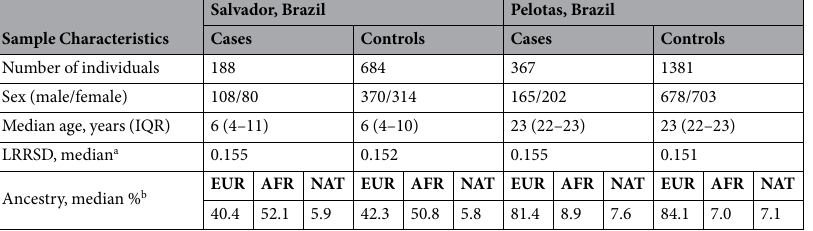
Table 1. Characteristics of the studied samples (after quality control). a Log 2 of R ratio standard deviation. b Ancestry proportions (ADMIXTURE method), EUR: European; AFR: African; NAT: Native American. IQR, interquartile